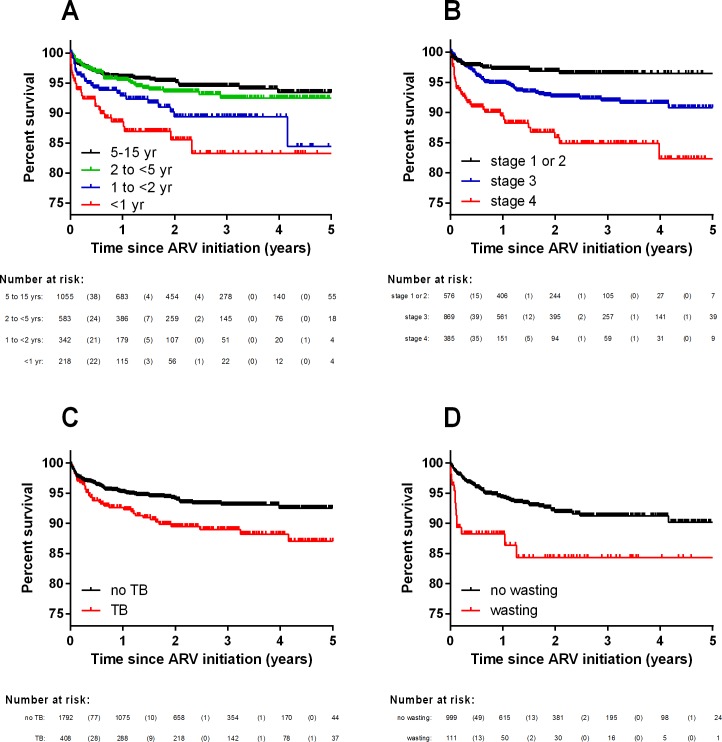
Survival curves for the Z-OCS pediatric cohort (n = 2203) by (A) age at enrolment; (B) clinical stage at diagnosis; (C) clinical diagnosis of tuberculosis at enrolment; and (D) wasting (weight for-length/height <-3SD). Survival analysis for wasting was restricted to patients <5 years of age.